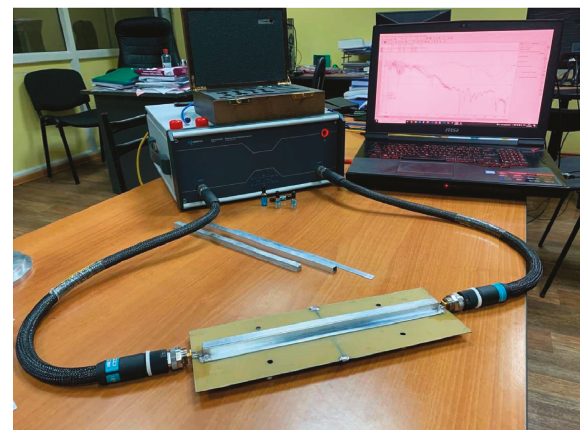
Figure 4: Vector network analyzer «Panorama» P4226 and an MF prototype with a corner passive